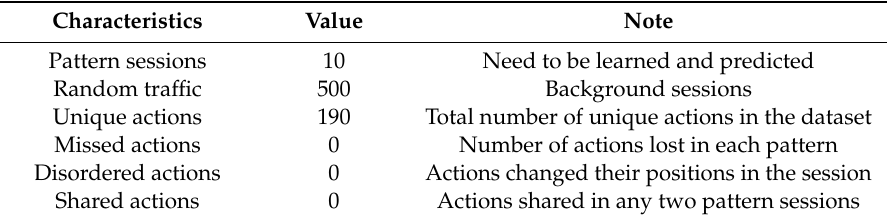
Table 1. The baseline